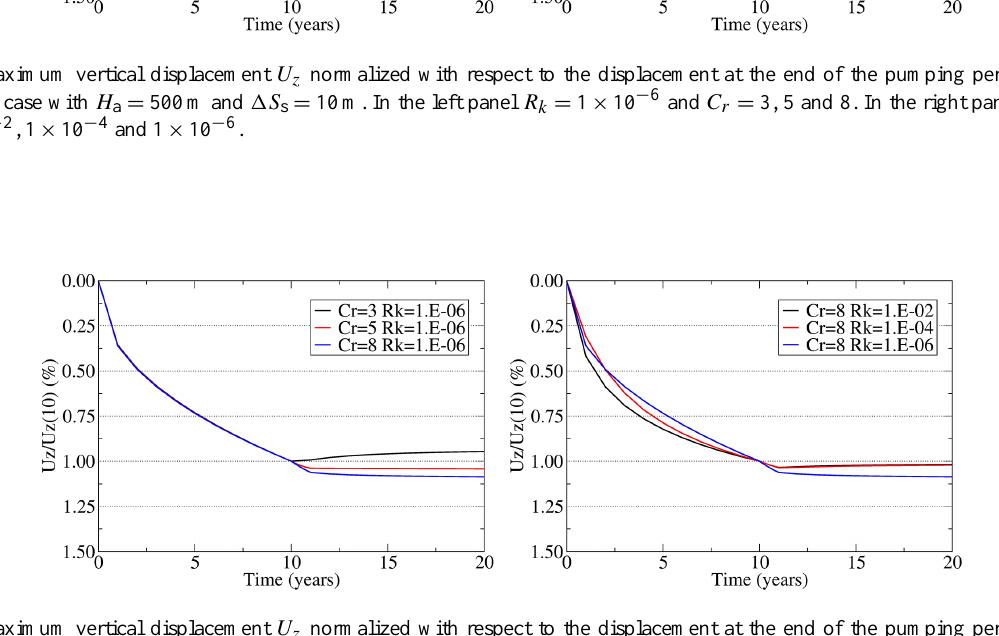
Figure 4. Maximum vertical displacement U z normalized with respect to the displacement at the end of the pumping period (10 years) U z (10) in the case with H a = 1000m and (cid:49)S s = 10m. In the left panel R k = 1 × 10 − 6 and C r = 3, 5 and 8. In the right panel C r = 8 and R k = 1 × 10 − 2 , 1 × 10 − 4 and 1 × 10 − 6 .